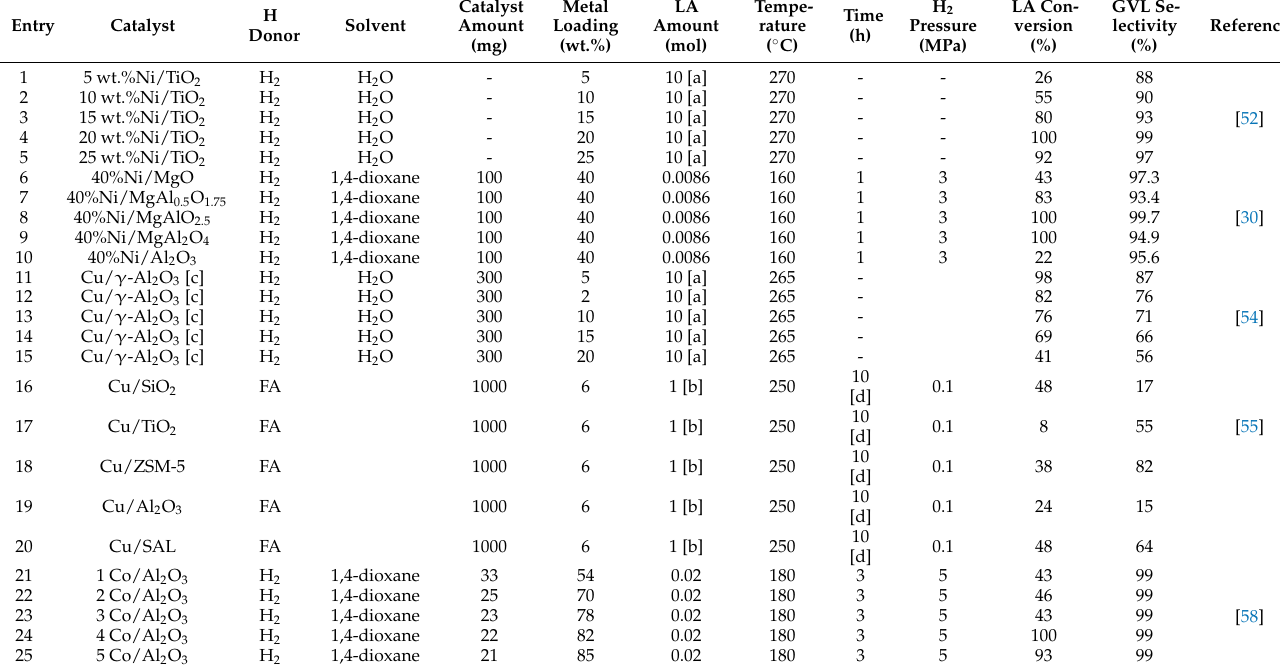
Table 1. Single non-precious metal catalysts for the hydrogenation of LA to